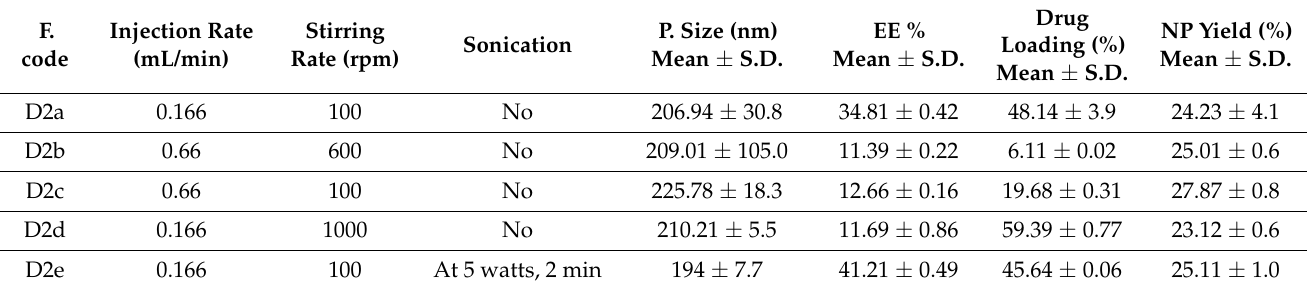
Table 2. Screening for process parameters and their effects ( n =